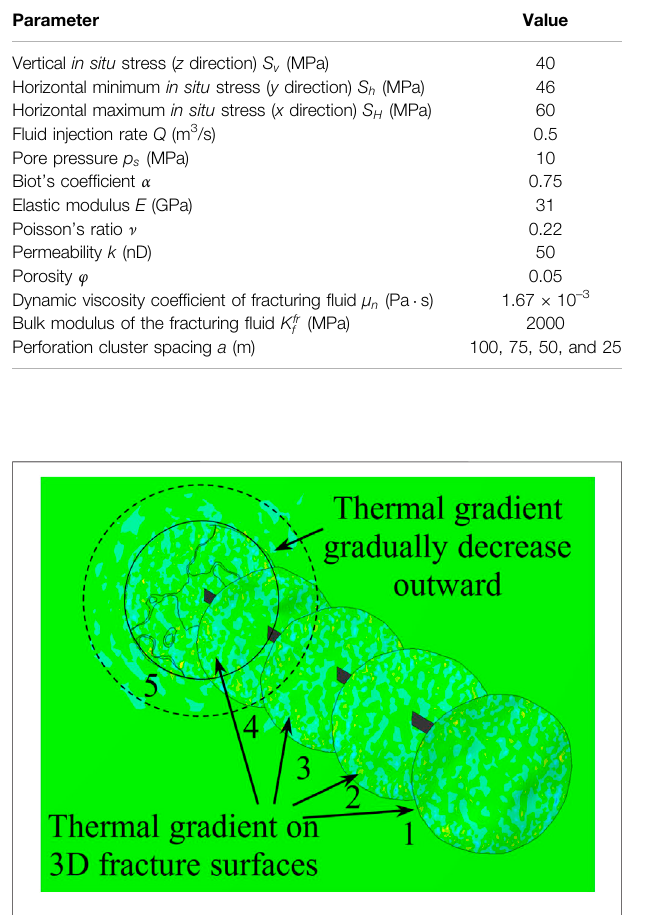
FIGURE 3 | Thermal gradient on the 3D fracture surfaces and surrounding rock.